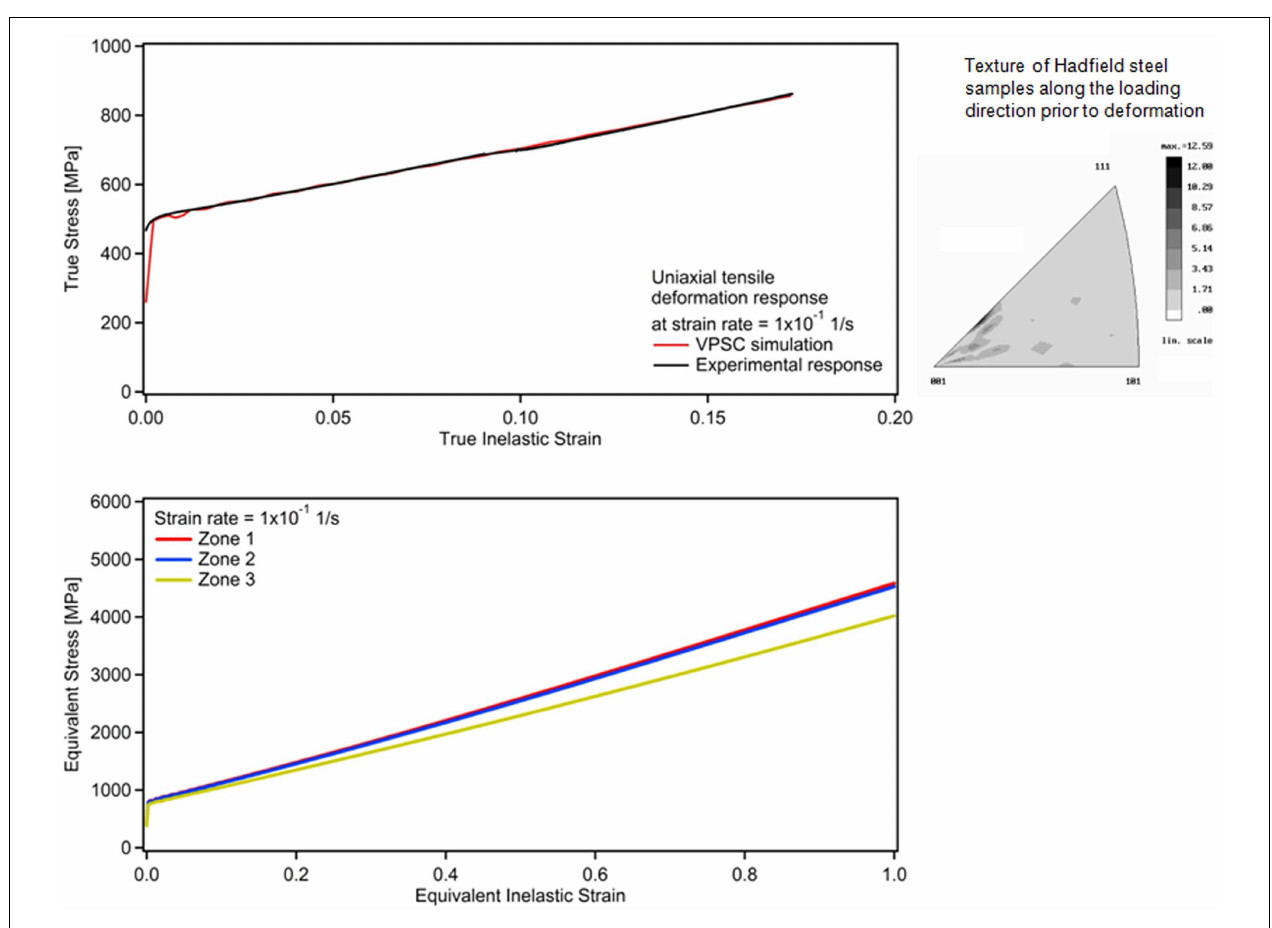
of the texture of all companion samples) . Bottom: the corresponding predicted equivalent stress–strain response for each zone within the impact sample based on the distribution of stress concentration ( Figure 4